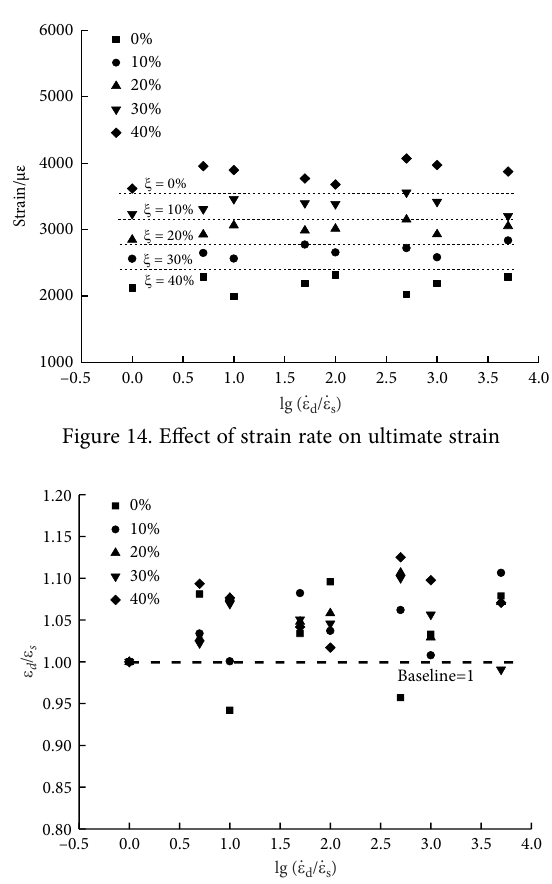
Figure 15. Effect of strain rate on the ultimate strain variation